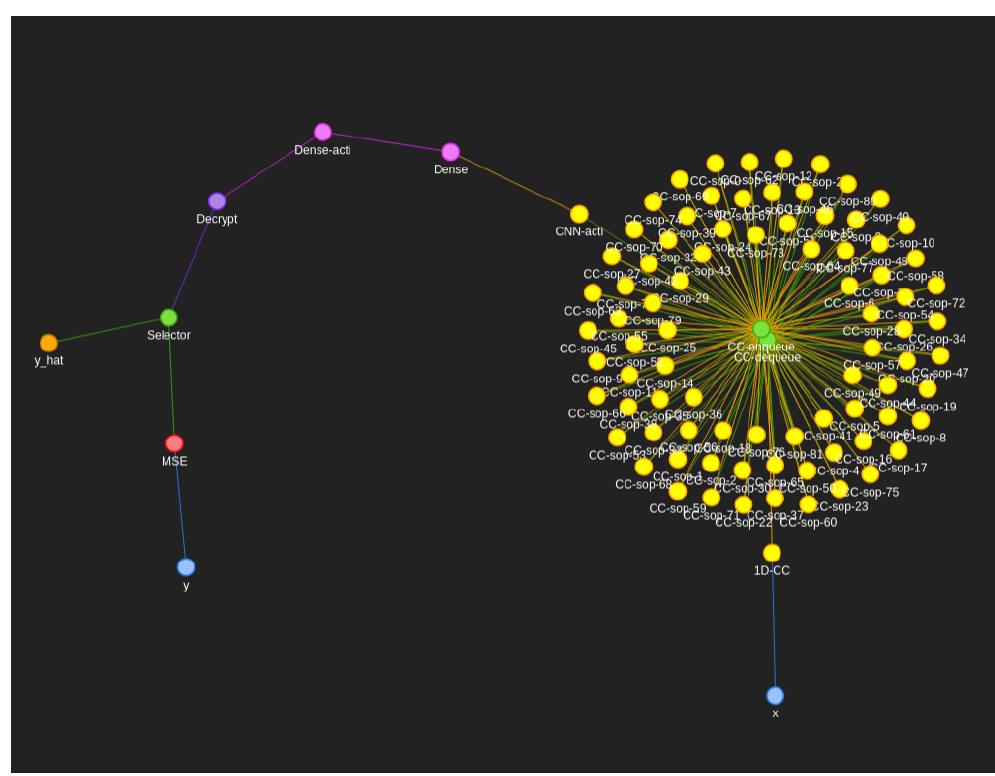
Figure 9. Strawberry yield/regression computational graph we call ‘constellation’, showing the colour coded graph representation and nodes used to train on strawberry yield based on environmental factors. Blue are input/encryption nodes. Yellow are convolutional-related nodes. Green are operational nodes necessary to “glue” the network together. Pink are dense/ANN nodes. Orange is the output prediction node. Red is the loss calculation node. Purple is an FHE-specific node used for decryption of the input data. Please see our documentation for closer detail